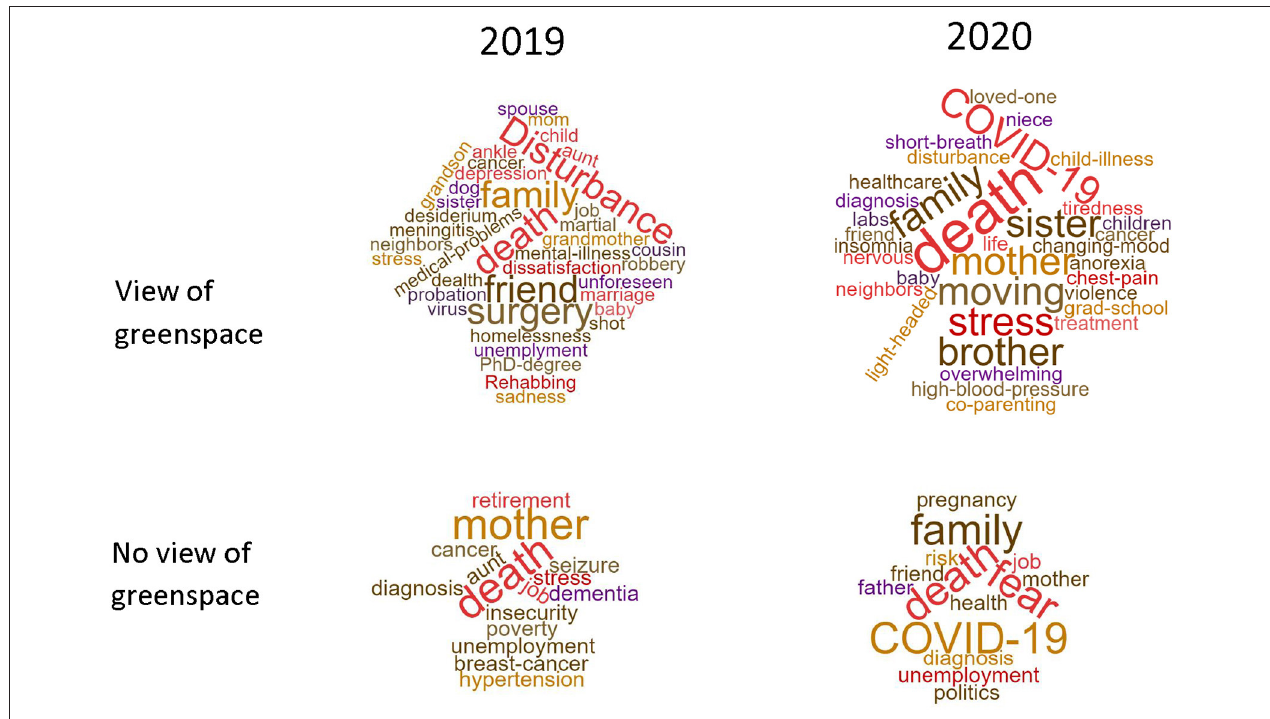
FIGURE 2 | Word clouds for major stressors in 2019 and 2020, stratified by visibility of greenspace from